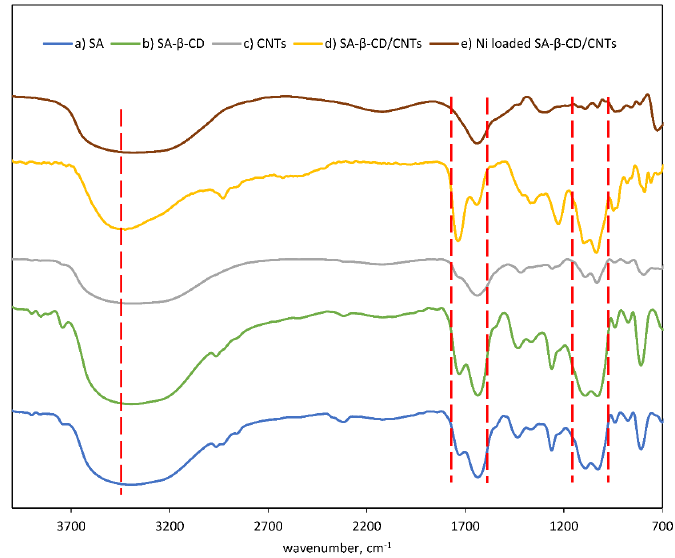
Figure 2. FTIR spectra of ( a ) SA hydrogel ( b ) SA −β− CD ( c ) CNTs ( d ) SA −β− CD/CNTs ( e ) Ni loaded SA −β− CD/CNTs to study the effect of incorporation of CNTs into hybrid hydrogel . After the adsorption of Ni(II), the FTIR absorption bands’ intensity usually shifted to lower and higher wavenumbers. The broad absorption peak represents that the stretching vibration of O ‐ H has broadened and shifted to 3387 cm − 1 . An intensive peak at 1736 and 1641 cm − 1 were combined to become a low absorption peak, and a low peak at 1639 cm − 1 indicates COO − became involved to interact with Ni(II) ions. The adsorption of Ni(II) could be further confirmed when the peak at 1227 cm − 1 disappeared, suggesting the C ‐ O to hydroxyl group has been replaced by Ni(II) ion. The results above concluded that OH